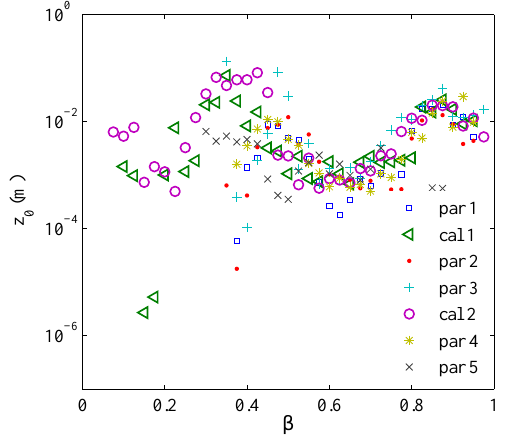
Fig. 9. IVM rating fitted by linear regression over five boat surveys covering the whole channel